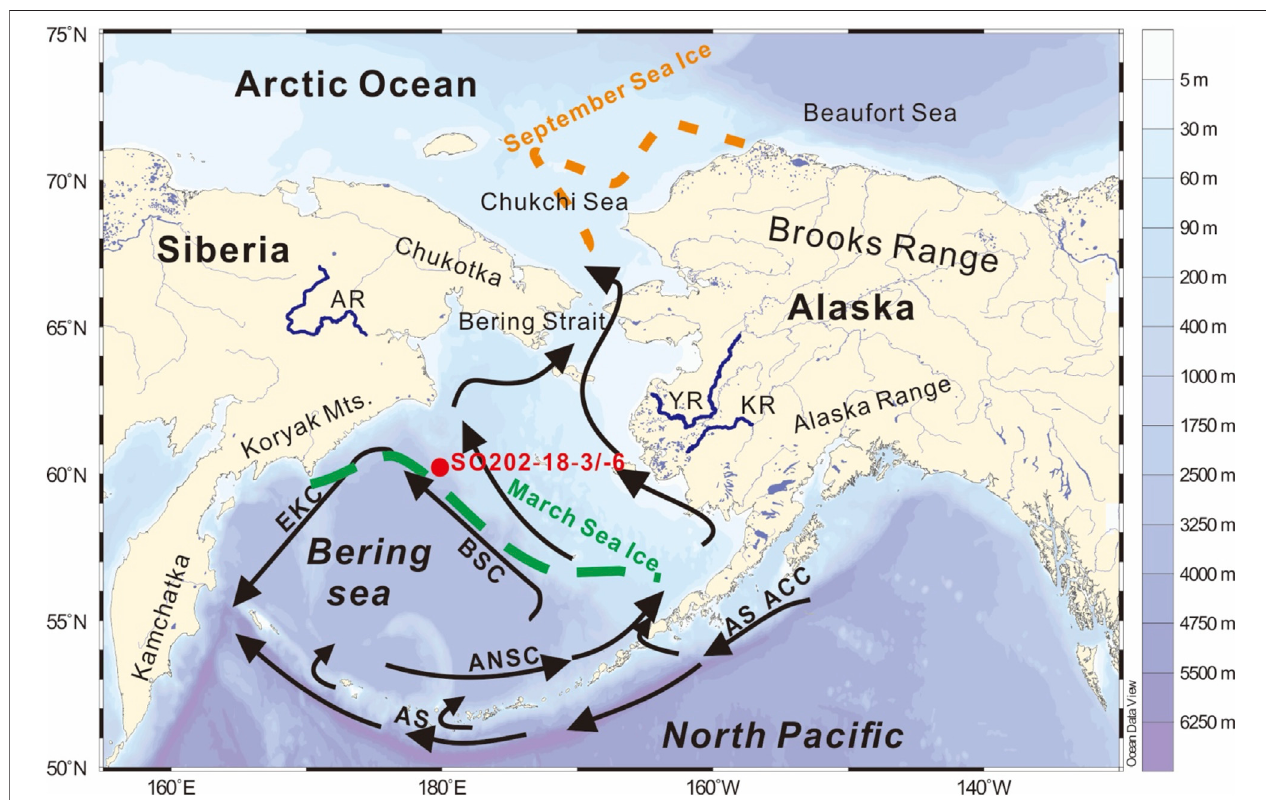
FIGURE1| Map oftheBering Sea withadjoining oceans and land masses and theirmountainranges aswellasthelocationofthestudy site (reddot) at theBering Slope.Themapalsoshowsbathymetry(Schlitzer,2002),oceancurrentsasblackarrows(Renetal.,2014;Wangetal.,2016),seasonalsea-icelimitsascoloreddashed lines (Danielson et al., 2011), and main rivers as blue lines (Naidu et al., 1995). Sediment cores SO202-18-3 and SO202-18-6 were collected during expedition 202 of research vessel SONNE in 2009 (Gersonde, 2012). Abbreviations: ACC – Alaska Coastal Current; ANSC – Aleutian North Slope Current; AS – Alaska Stream; BSC – Bering Slope Current; EKC – East Kamchatka Current; AR – Anadyr River; YR – Yukon River; KR – Kuskokwim River.